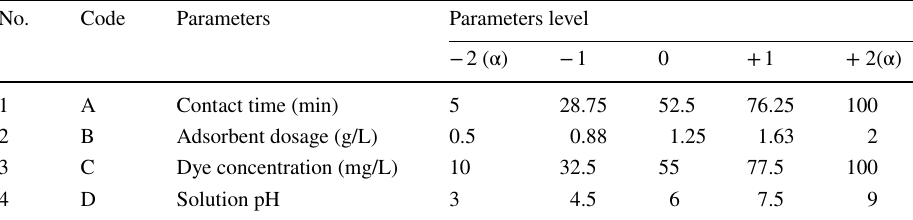
Table 2 Operational range of input variables as coded level and actual units for the adsorption of AG 20 onto